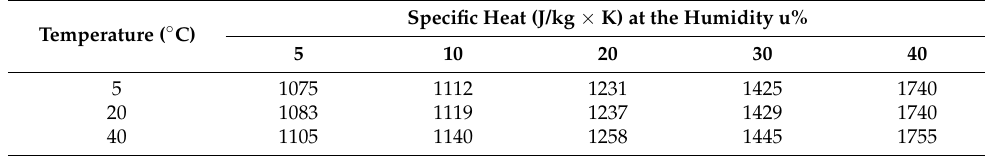
Table 5. Specific corn seed heat depending on temperature and humidity.